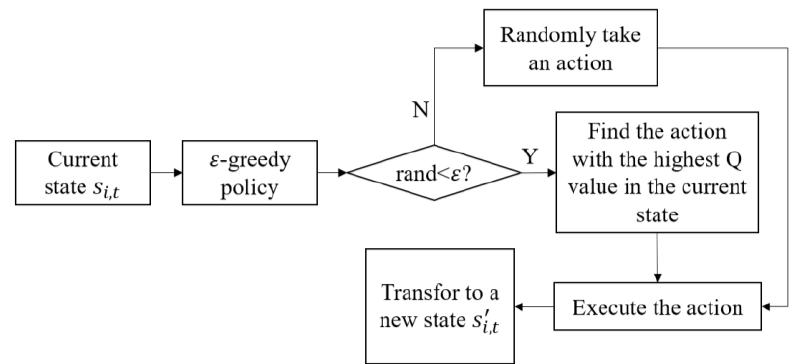
Figure 3. The introduction of 𝜀 -greedy